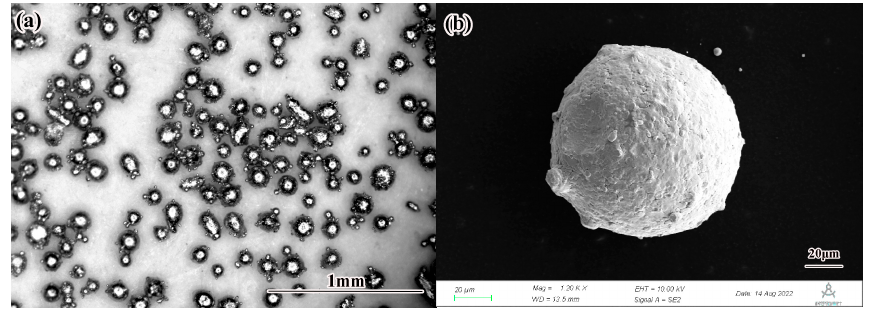
Figure 1. Scanning electron microscope image of 316L steel powder: ( a ) 20× ( b ) 1200×. Table 1. Particle size distribution of 316L stainless steel powder.